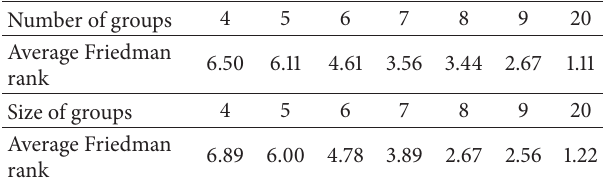
Table 10: Friedman test on the effect of number of groups and group size.